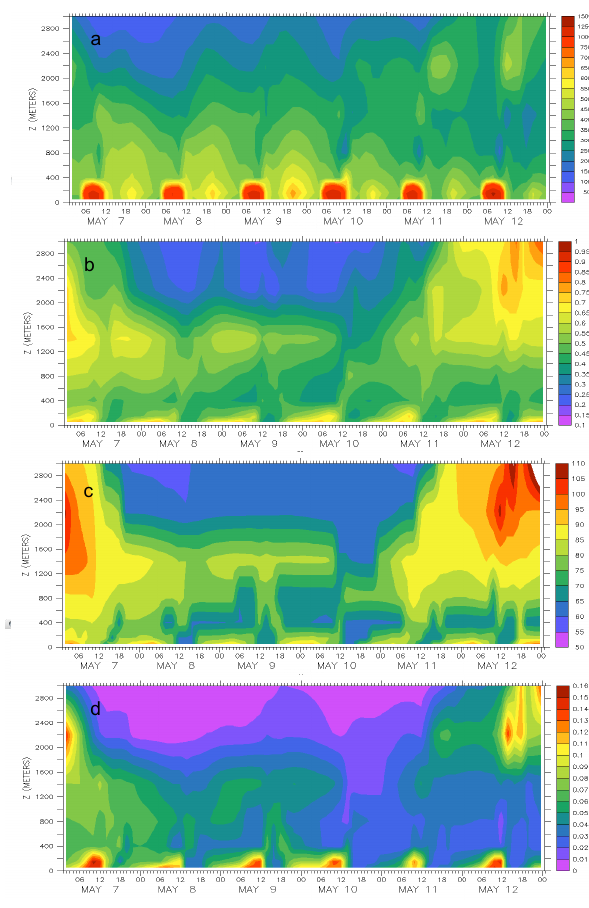
Fig. 8. (a) Fine mode particle concentration (cm − 3 ) , (b) RH, (c) Figure 8. a) Fine mode particle concentration (cm -3 ), b) RH, c) median wet radius of the median wet radius of the soluble accumulation mode (nm), and (d) soluble accumulation mode (nm), and d) the scattering coefficient (km -1 ) simulated for the dry the scattering coefficient (km − 1 ) simulated for the dry period (7–13 period (May 7-13).